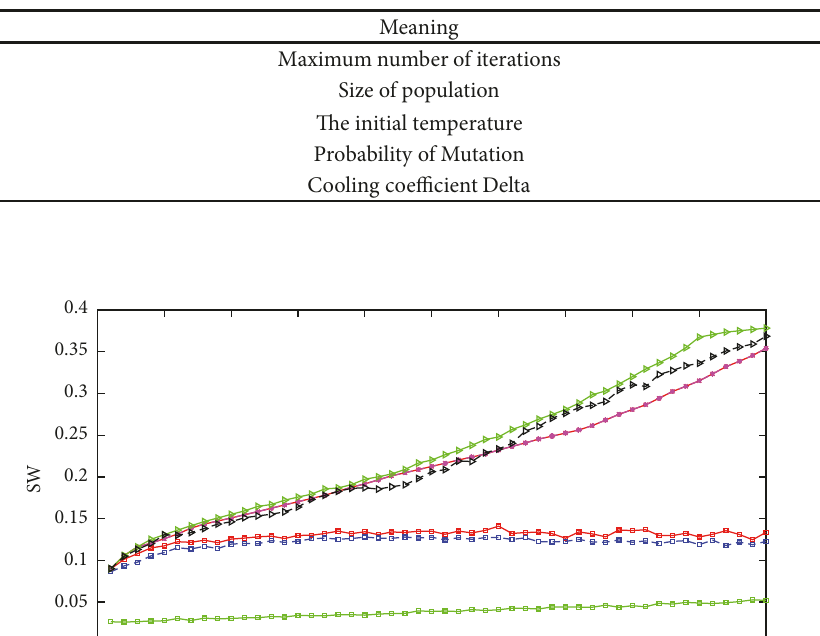
Table 1: Parameters of the experiment.